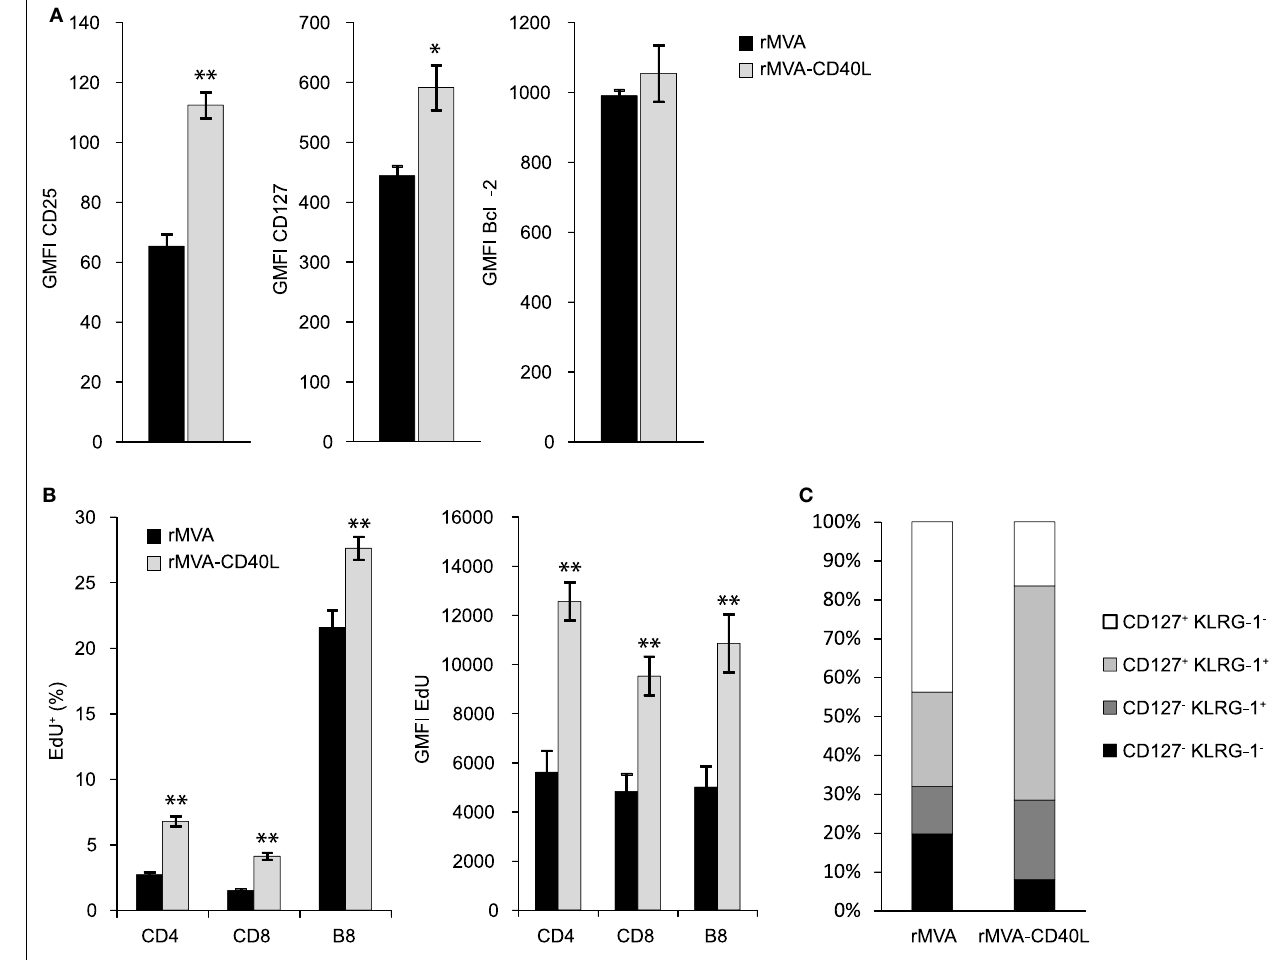
FIGURE 7 | rMVA-CD40L immunization influences the phenotype and the proliferation rate of CD8T cells . C57BL/6 mice were immunized with rMVA and rMVA-CD40L. Five days later expression of CD25, CD127, and Bcl-2 in splenic B8-specific CD8T cells was analyzed flow cytometrically. (A) Bars represent the mean ± SEM GMFI (gated on B8-dextramer + CD8T cells). In order to measure cell proliferation, mice were treated with the thymidine analog EdU on day 5 after immunization. EdU incorporation into